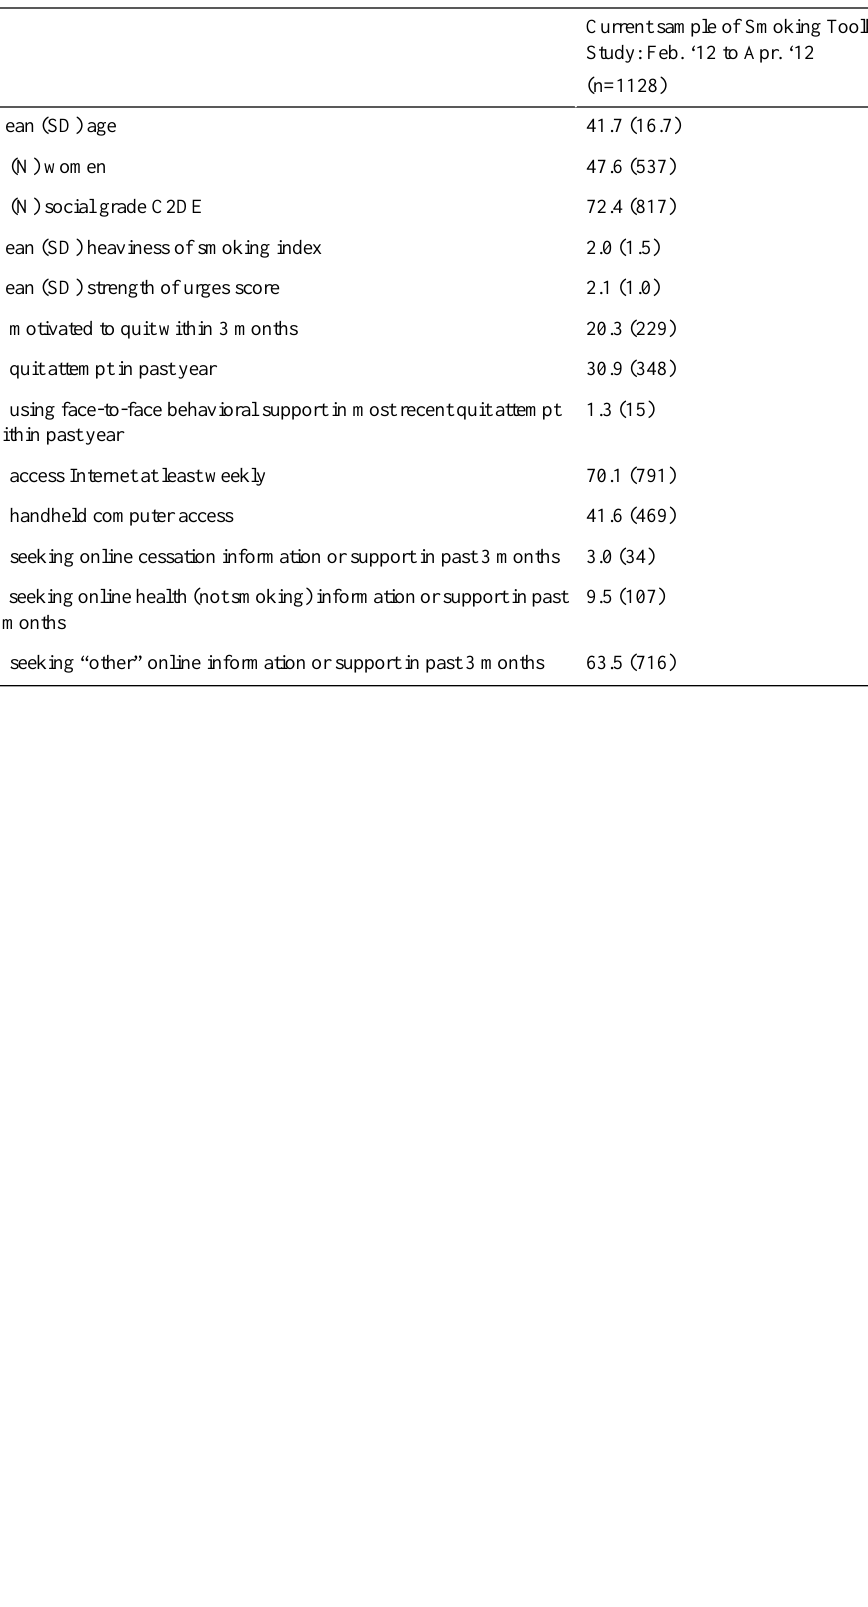
Table 1. Characteristics of current